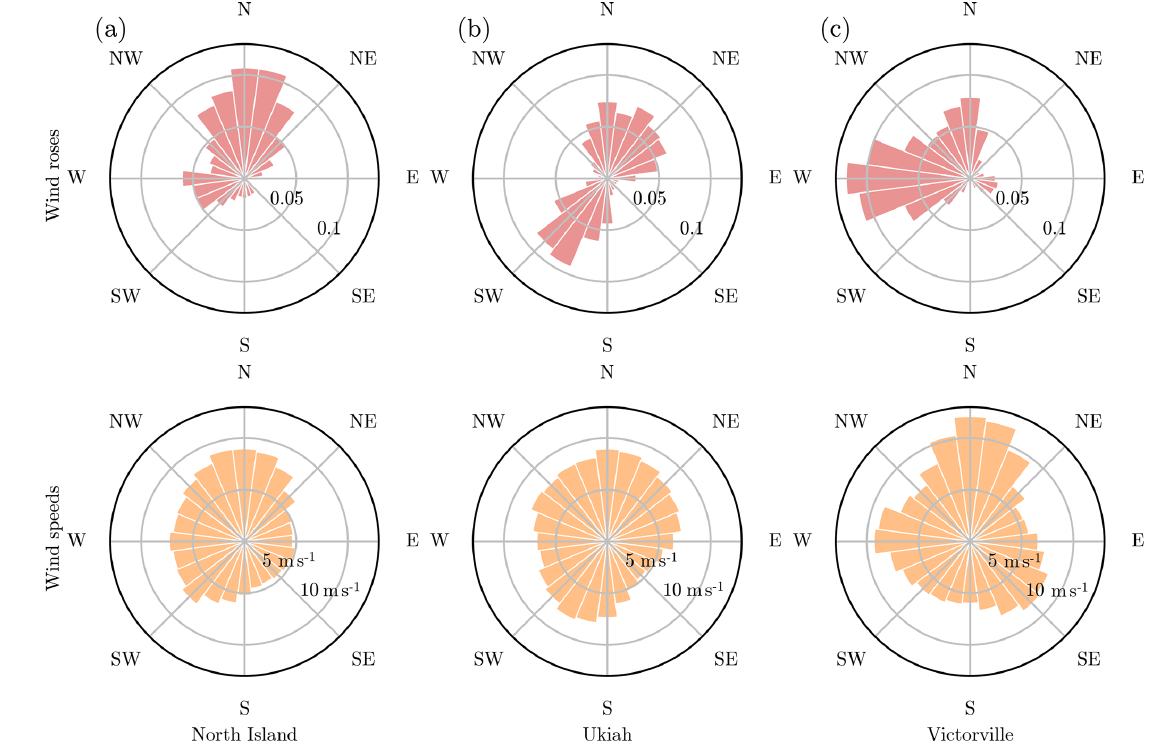
Figure 6. The three wind roses and associated average wind speeds used in this study. The wind resources are from (a) North Island, California, (b) Ukiah, California, and (c) Victorville, California.